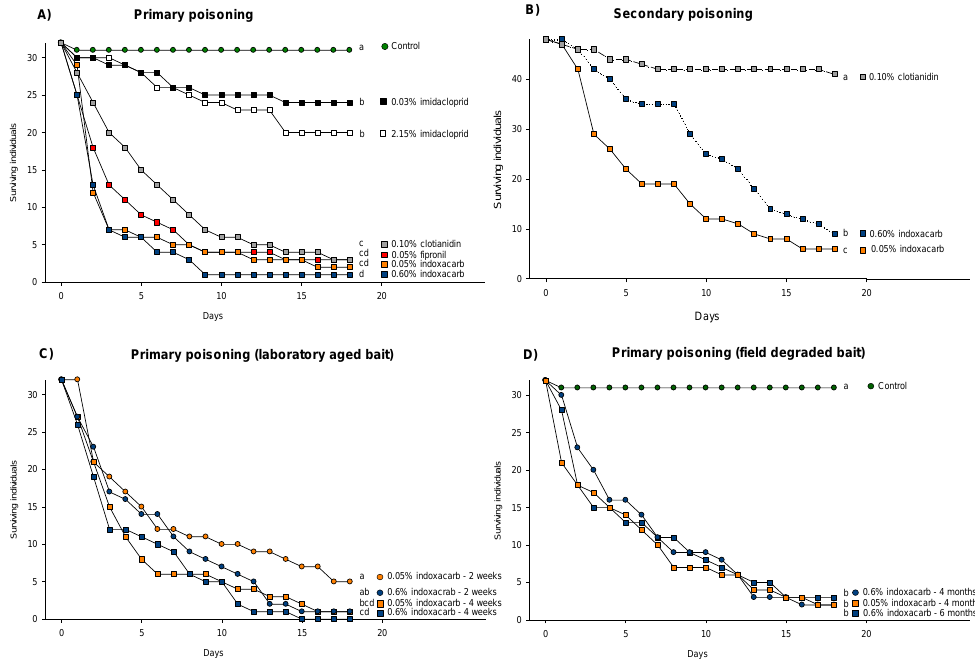
Figure 3. Survival of Ctenolepisma longicaudata in bio-assays with ( A ) five commercial baits presented in competition with a commonly preferred food source (flaked oat grains), ( B ) access to conspecifics having died from ingestion of three different baits, ( C ) two commercial baits having been aged for two or four weeks before being presented in competition with a commonly preferred food source (flaked oat grains) and ( D ) two commercial baits having been aged four or six months under field conditions before being placed in the arena as the only food source available. The different letters (a, b, c, and d) indicate significant differences in survival between pairs of treatments (Kaplan-Meier survival analysis, the log-rank test with the p -Value limit set p < 0.05). The commercially available baits that were tested are: (white) Maxforce white IC, (gray) Maxforce Platin, (red) Goliath gel, (blue) Advion cockroach (black) Maxforce quantum and (yellow) Advion ant. The control treatment is assigned a green colour.